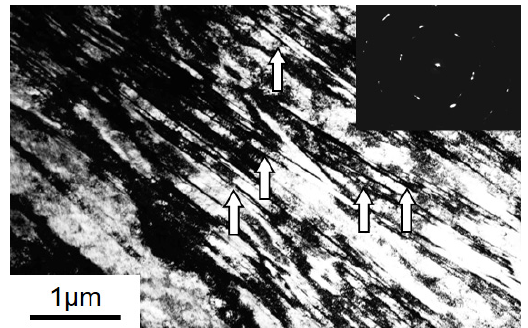
Figure 4. EBSD map with color ‐ coding according to the inverse pole figure after one ‐ pass ECAP. 13 grains were analyzed in the selected zone as illustrated in the inset. Black and white lines denote high ‐ angle grain boundaries ( θ ≥ 15°) and ∑ 3 (60°<111>) grain boundaries, respectively.